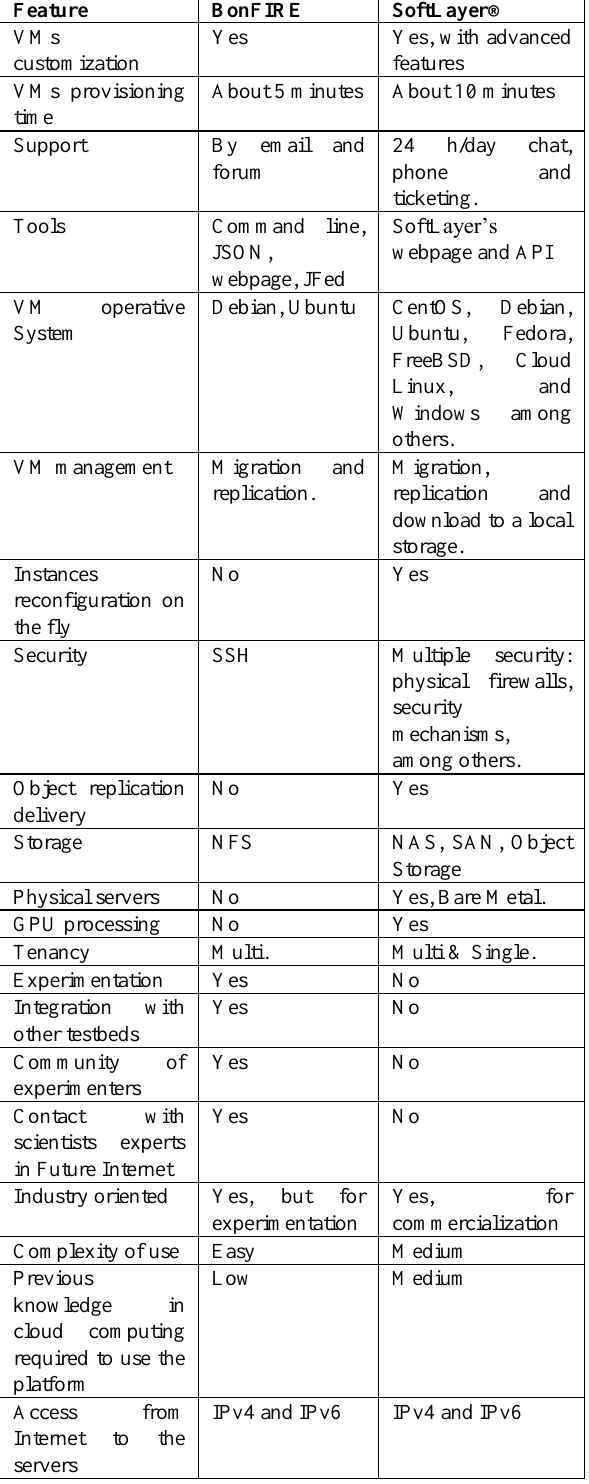
Table 3. Comparison between BonFIRE and